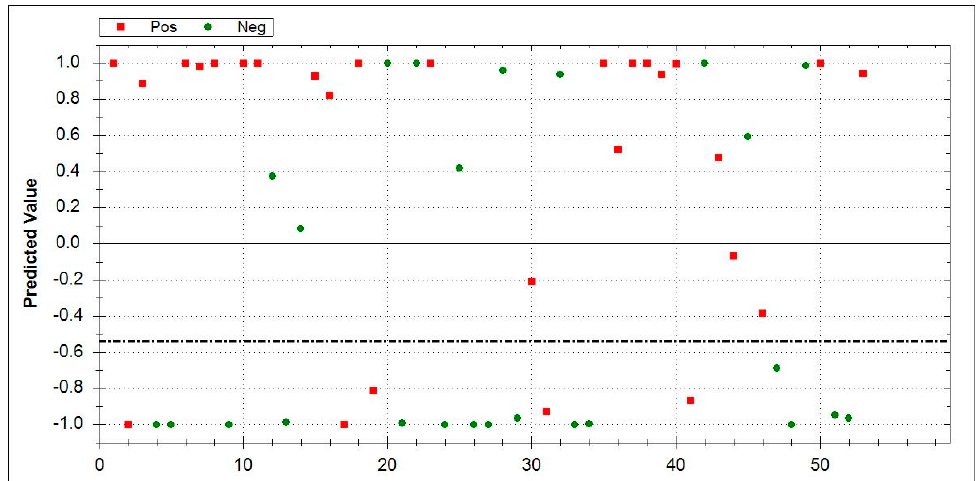
Figure 6. Direct comparison between COP ( n = 28, red squares) vs. CTD-ILD ( n = 25, green dots). Abbreviations: COP area 0-1: Red squares indicate correctly recognized COP patients. Green dots denote false positive patients. CTD-ILD area 0- -1: Green dots represent correctly identified CTD-ILD, while red squares mark false negative results. The dotted line is inserted around the threshold for uncertain cases and included two patients. Abbreviations: COP-cryptogenic organizing pneumonia, CTD-ILD-connective-tissue diseases-associated ILD.